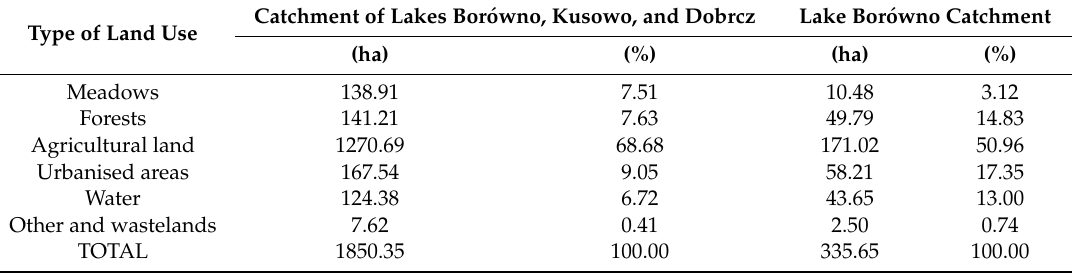
Table 2. Land use in the catchment of Lake Bor ó wno and the catchment of the three lakes, Bor ó wno, Kusowo, and Dobrcz (calculated on the basis of satellite image Sentinel, 2018